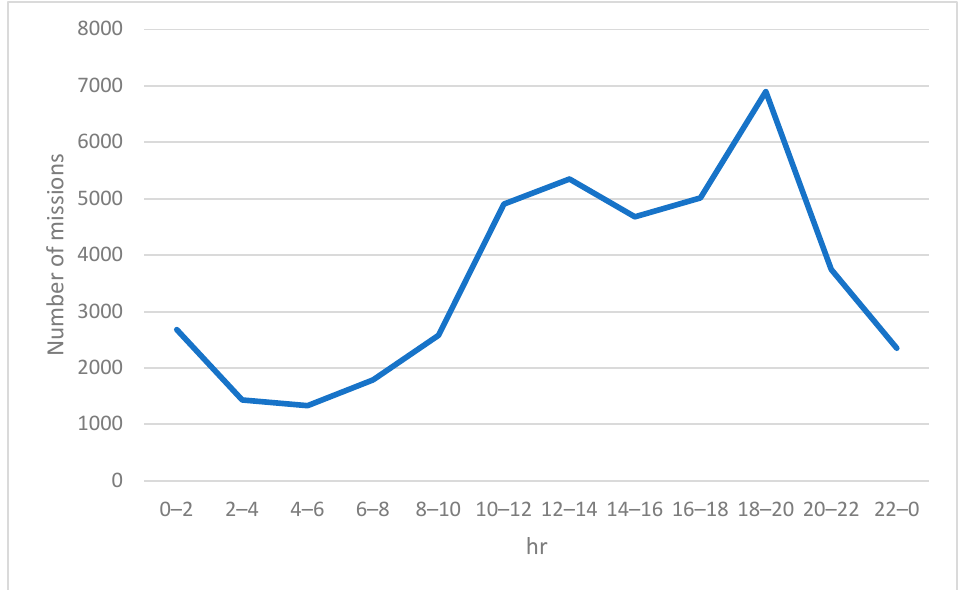
Figure 4. Volume of regular missions performed by the UAVs within a day.